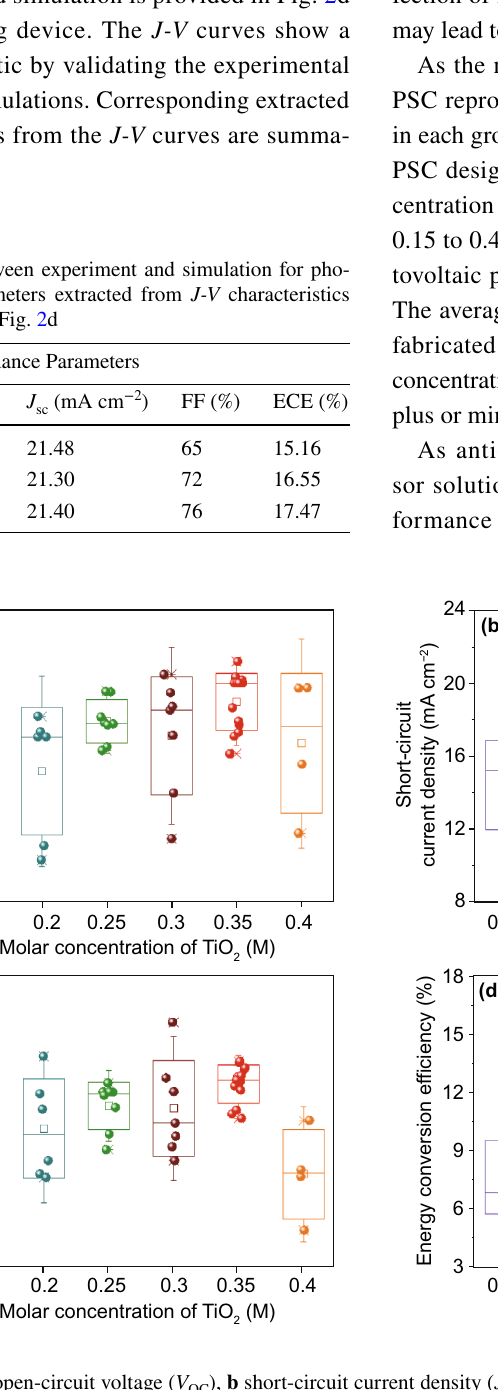
Fig. 3 Average values of a open‑circuit voltage ( V OC ), b short‑circuit current density ( J SC ), c fill‑factor ( FF ), and d energy conversion efficiency ( ECE ) obtained from resultant 13 fabricated devices in each group while varying the molar concentration of the TiO 2 precursor solution from 0.15 to 0.40